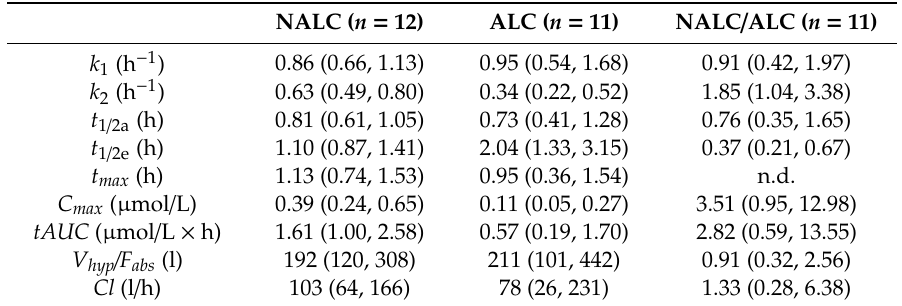
Table 4. Plasma kinetics of epicatechin after consumption of a beverage prepared with nonalkalized and alkalized cocoa—results from the pharmacokinetic